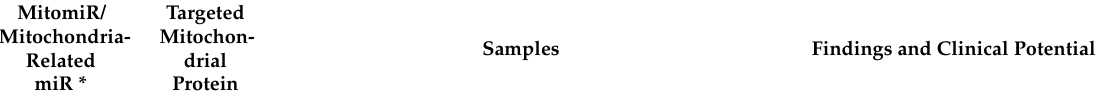
Samples Findings and Clinical